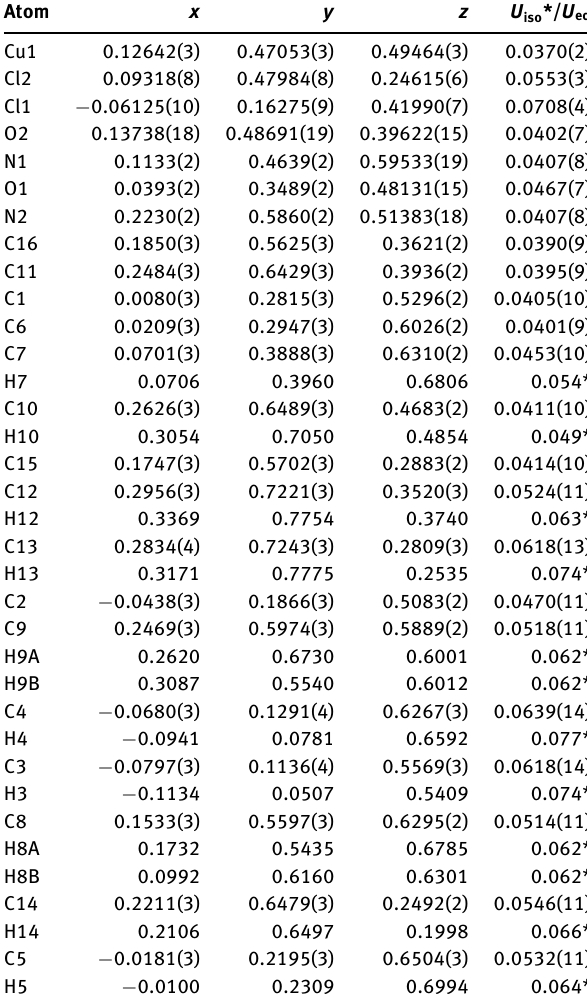
Table 2: Fractional atomic coordinates and isotropic or equivalent isotropic displacement parameters (Å 2